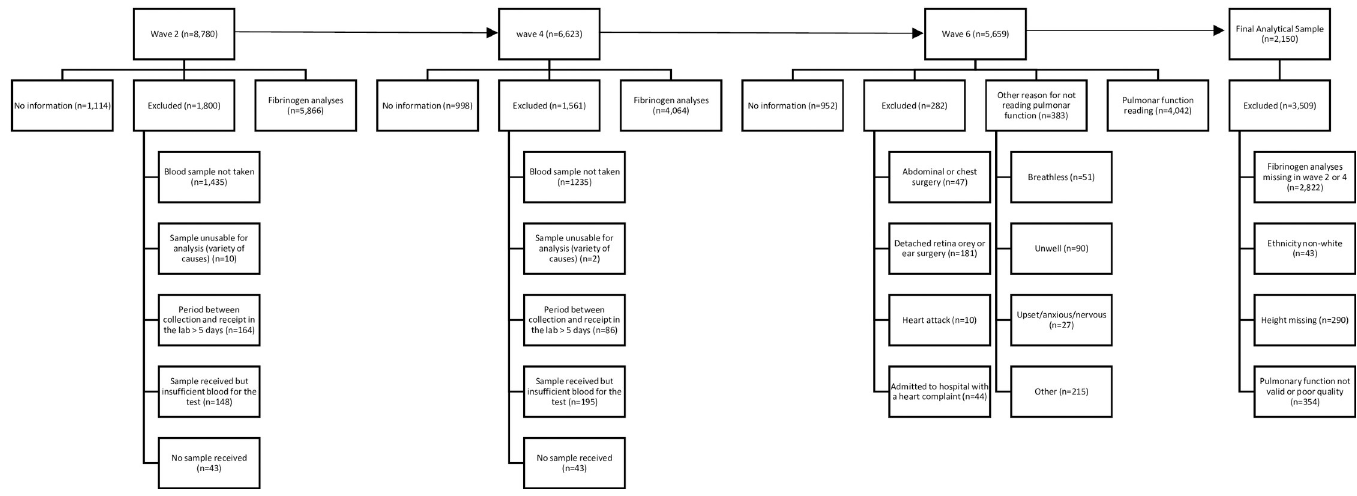
Fig 1. Flowchart describing the sample selection from waves 2 (2004/5), 4 (2008/9) and 6 (2012/13), The English Longitudinal Study of Ageing, England, 2004 to 2013.